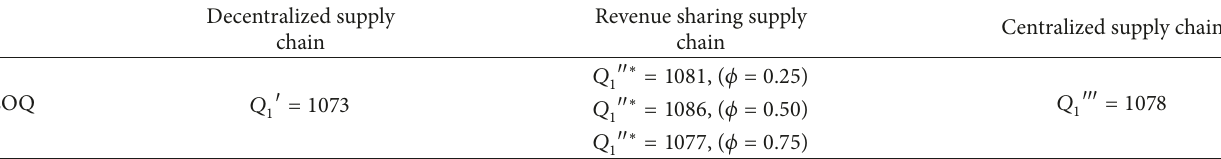
Table 1: The EOQ under the three situations of block chain technology and random